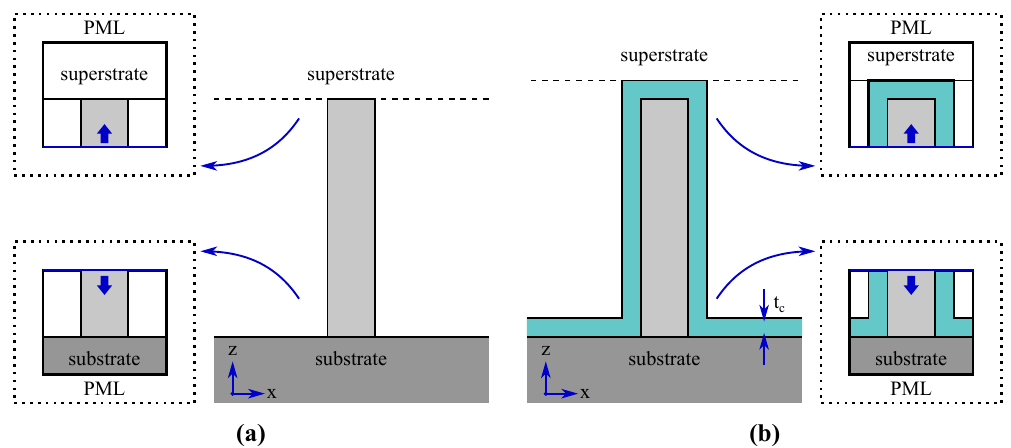
Figure 2. Nanowire monomer waveguide xz -plane cross-sections. ( a ) uncoated nanowire; ( b ) coated nanowire. The call-outs show the computational domains (enclosed in perfectly matched layers, PMLs) of the simulations with launching of the guided mode from the input port indicated with